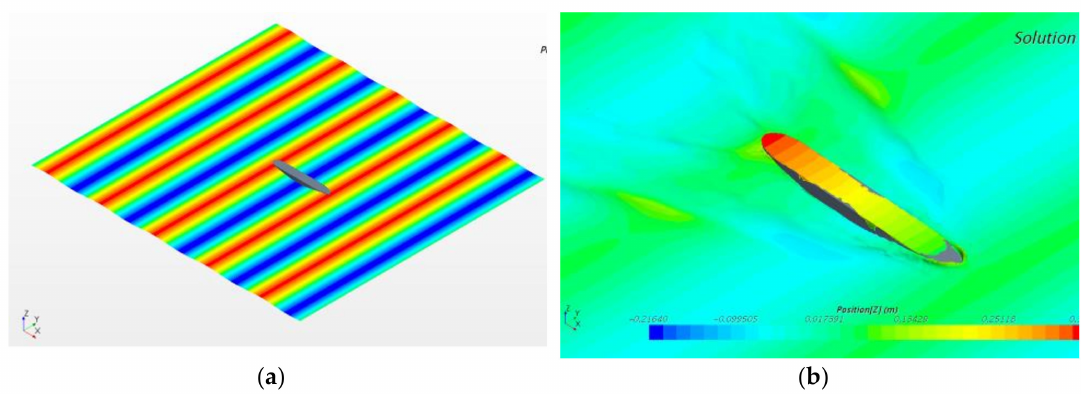
Figure 14. Numerical simulation of ship motion in head regular wave: ( a ) overview of initial state; ( b ) green water on deck.